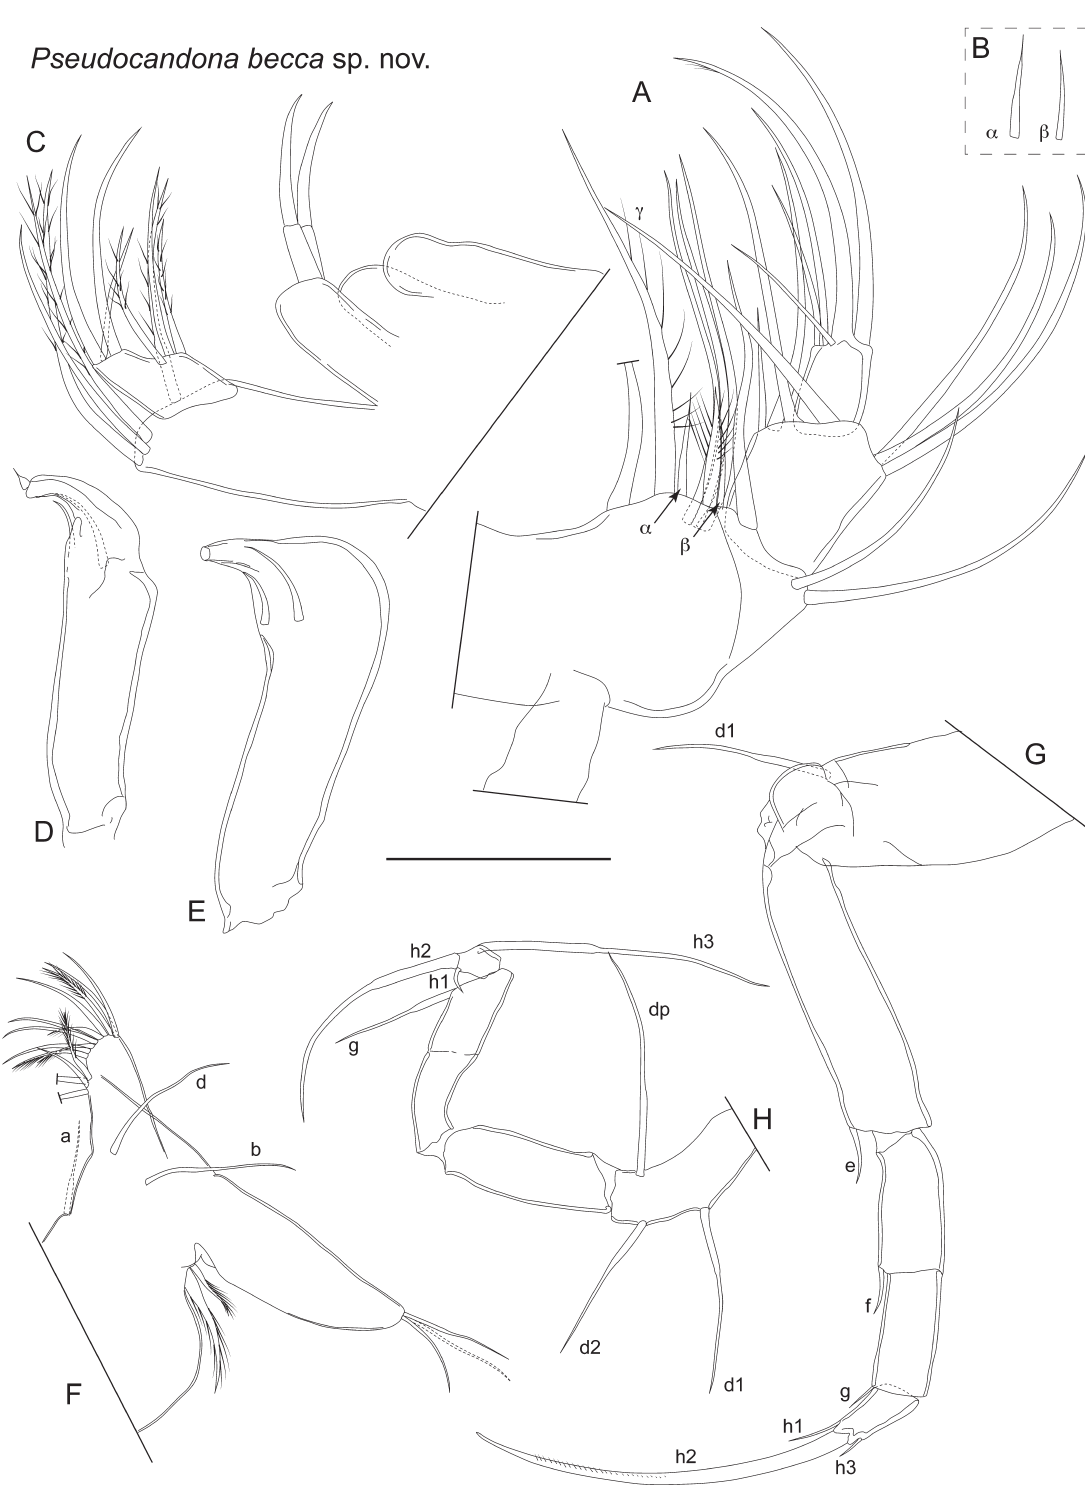
Fig. 4. Pseudocandona becca sp. nov. A . Female mandibular palp (LBM 1430006267). B . Alpha and beta setae of the mandibular palp (LBM 1430006267). C . Female maxillula (setae on endites not drawn) (LBM 1430006265). D–E . Left and right male fifth limb palps (LBM 1430006264). F . Female fifth limb (LBM 1430006265). G . Male sixth limb (LBM 1430006264). H . Male seventh limb (LBM 1430006264). Scale bar: A–C = 66 µm; D–H = 127